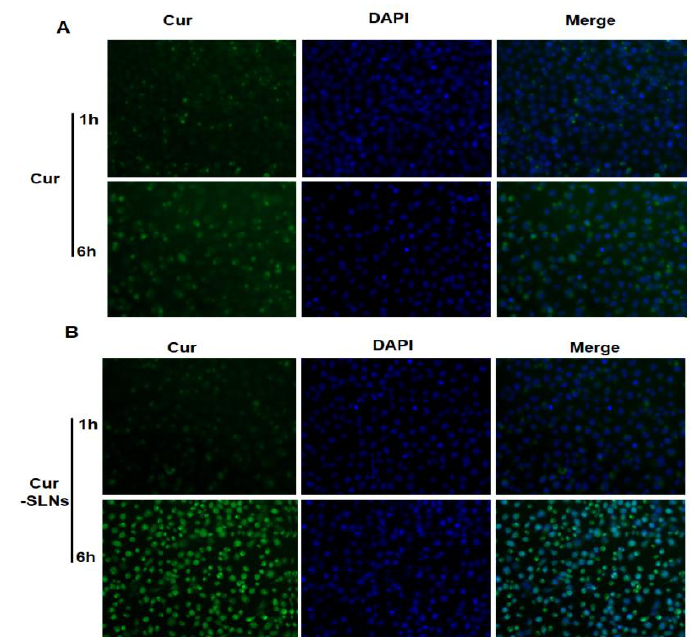
Figure 3. Representative fluorescent images from the ( A ) curcumin and ( B ) Cur-SLNs internalization in SKBR3 cancer cell line at 1 h and 6 h. Left panel refers to internalized curcumin, that shows green fluorescence color; middle panel is nuclei stained by 4 ′ ,6-diamidino-2-phenylindole (DAPI), thus exhibiting blue regions; right panel is an overlay image of both DAPI and curcumin.